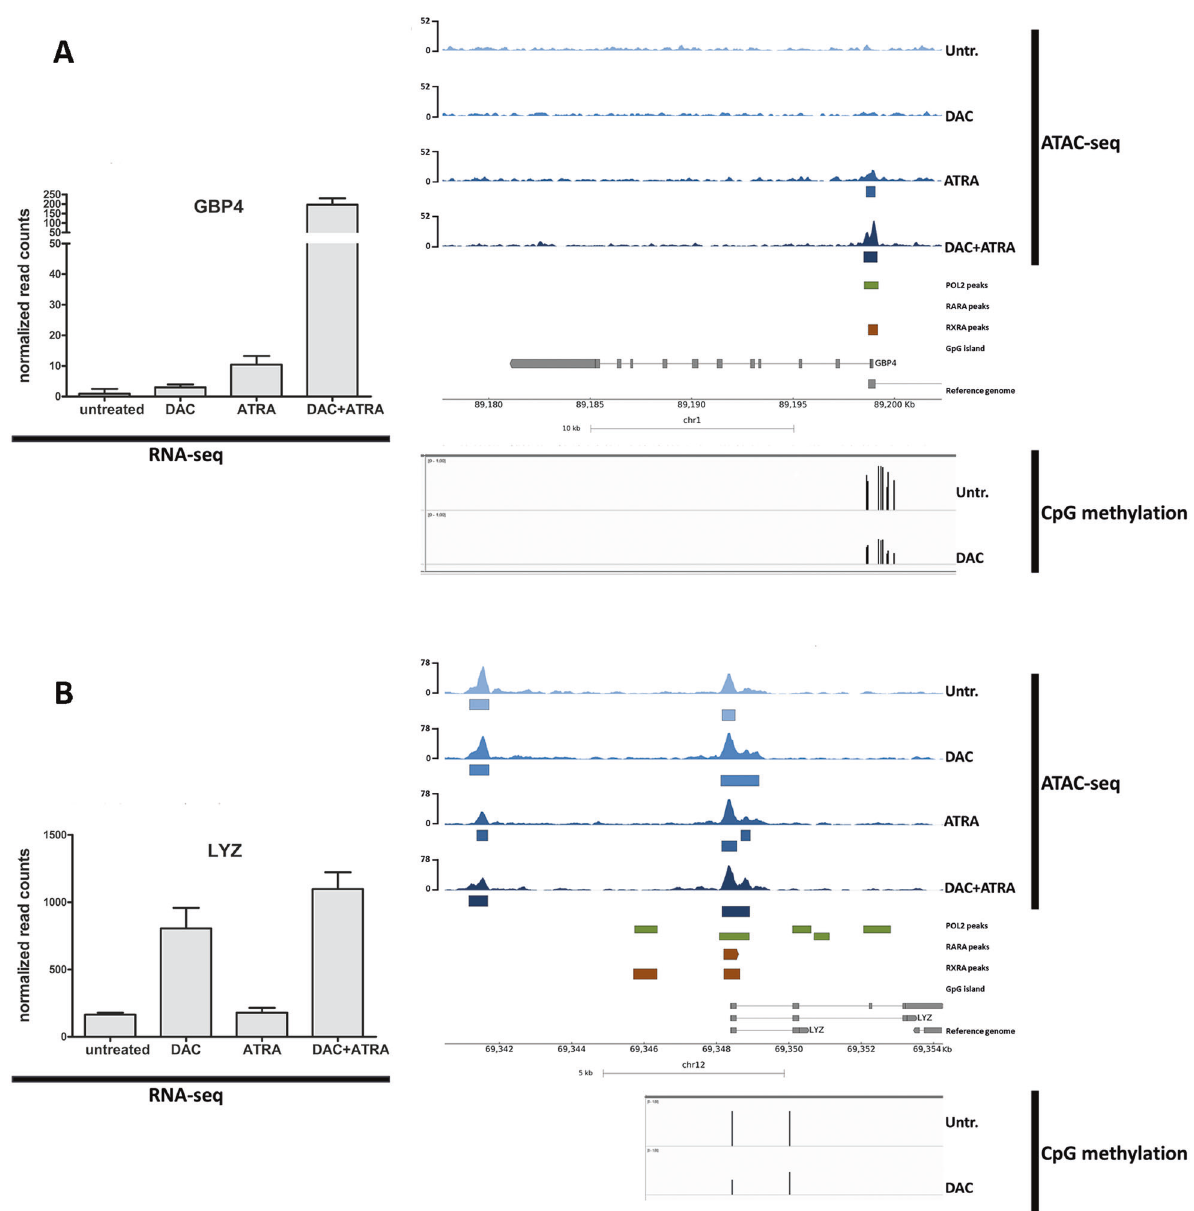
Fig. 5 Transcriptional induction of GBP4 and LYZ by DAC and ATRA is associated with changes in chromatin accessibility. A , B mRNA expression (normalized read-counts) of GBP4 ( A ) and LYZ ( B ) of both untreated U937 cells and U937 after treatment with either DAC, ATRA, or DAC + ATRA at 72 h was determined by RNA-seq (left panel). Chromatin accessibility of these cells and treatment modes was determined by ATAC-seq (upper right panel). Blue boxes below the ATAC-seq track represent signi fi cant effects. Annotations for POLR2A binding sites (green boxes), retinoic acid receptors RARA and RXRA (brown boxes) and CpG islands (black boxes) were extracted from ChiP-seq data accessed from ENCODE and GEO (right panel). CpG methylation data of U937 cells untreated or treated with DAC were determined by In fi nium HumanMethylation450 BeadChip Assay [8] (lower right